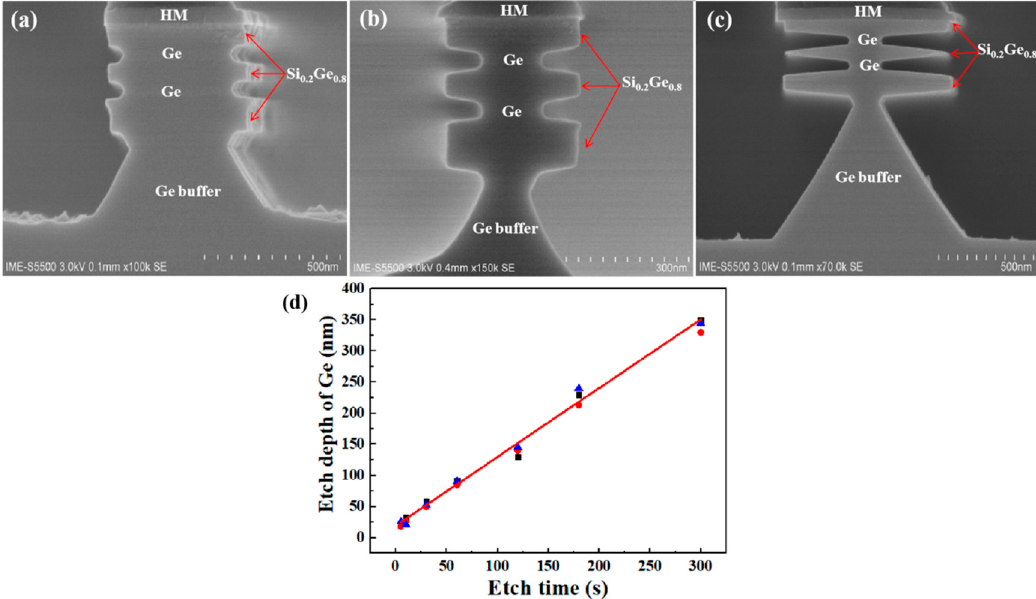
Figure 8. The Ge buffer/Si 0.2 Ge 0.8 /Ge stack structure immersed in H 2 O 2 (30%) solution for different etching times: ( a ) 30 s, ( b ) 1 min, and ( c ) 5 min. ( d ) The relative etching depth of Ge in H 2 O 2 solution is linear with the etching time.